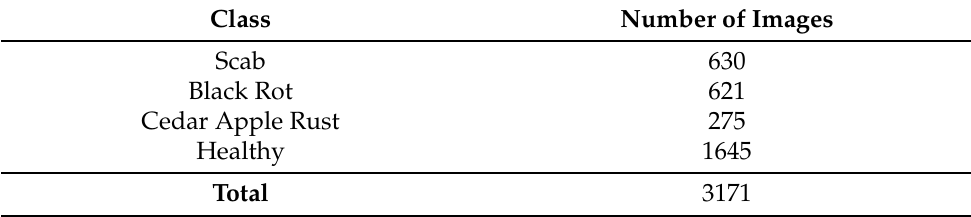
Table 1. Apple leaf disease dataset.